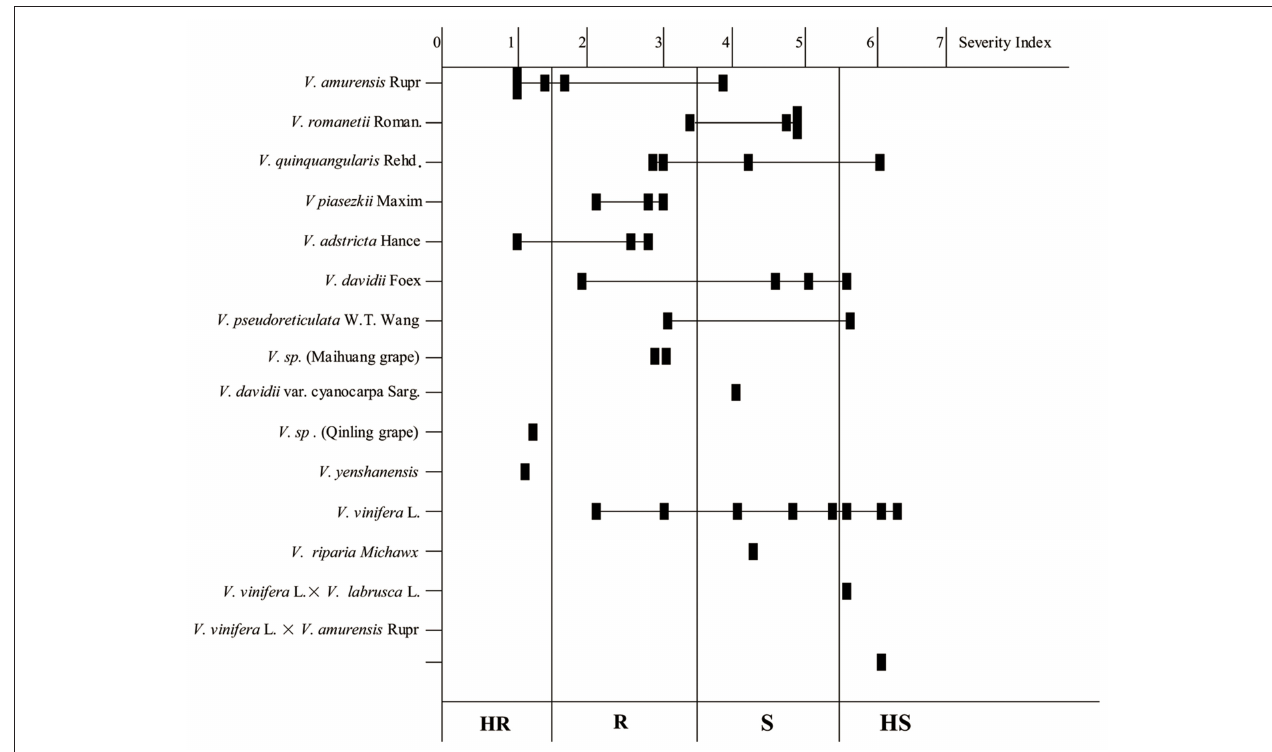
FIGURE 1 | Histogram showing the resistance levels of the 41 tested Vitis genotypes to B. cinerea . Solid squares represent the average of the severity index. HR, Highly Resistant (Scores: 0–1.5); R, Moderately Resistant (Scores: 1.51–3.5); S, Moderately Susceptible (Scores: 3.51–5.5); HS, Highly Susceptible to (Scores: